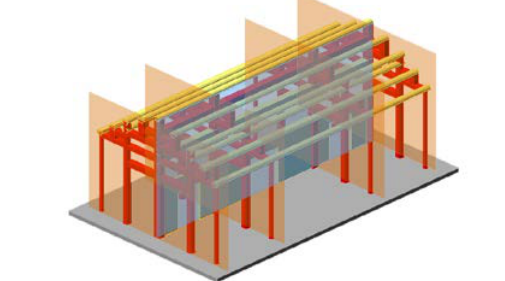
Figure 7 Overall Layout of the Hall of